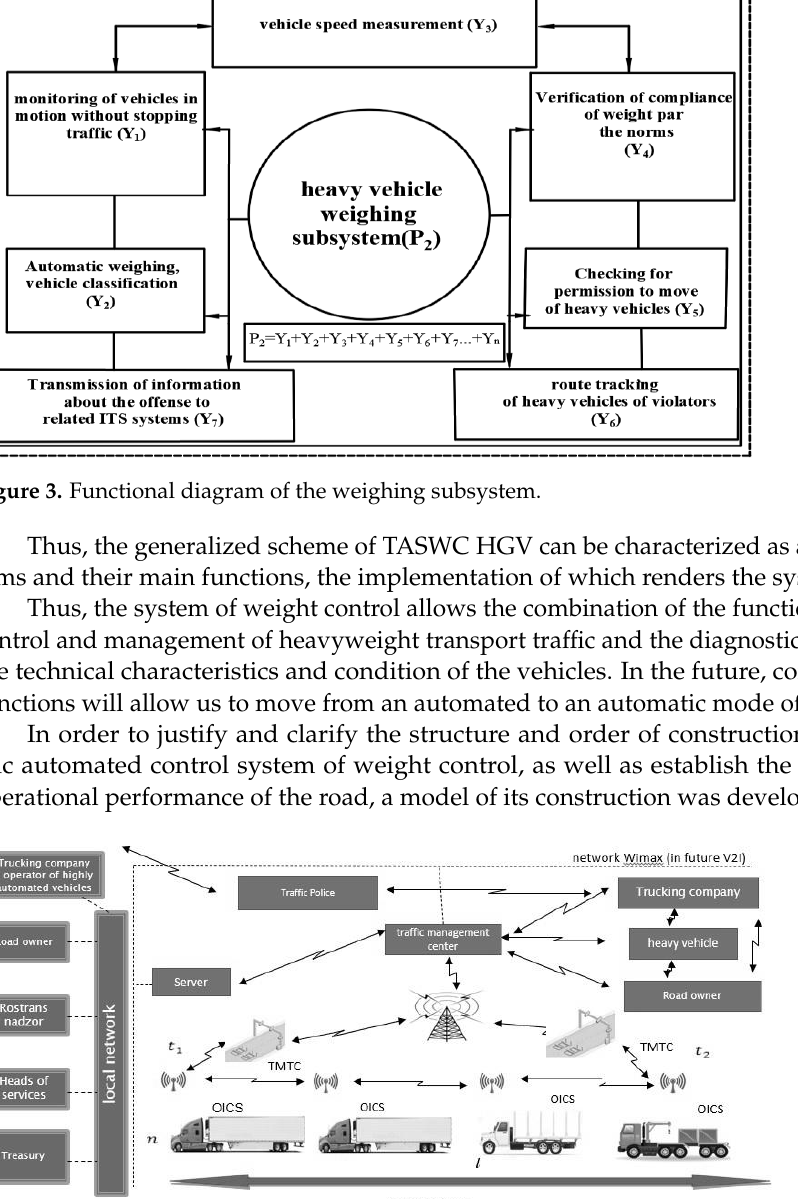
Figure 4. Model for the construction of the TASWC HGV .